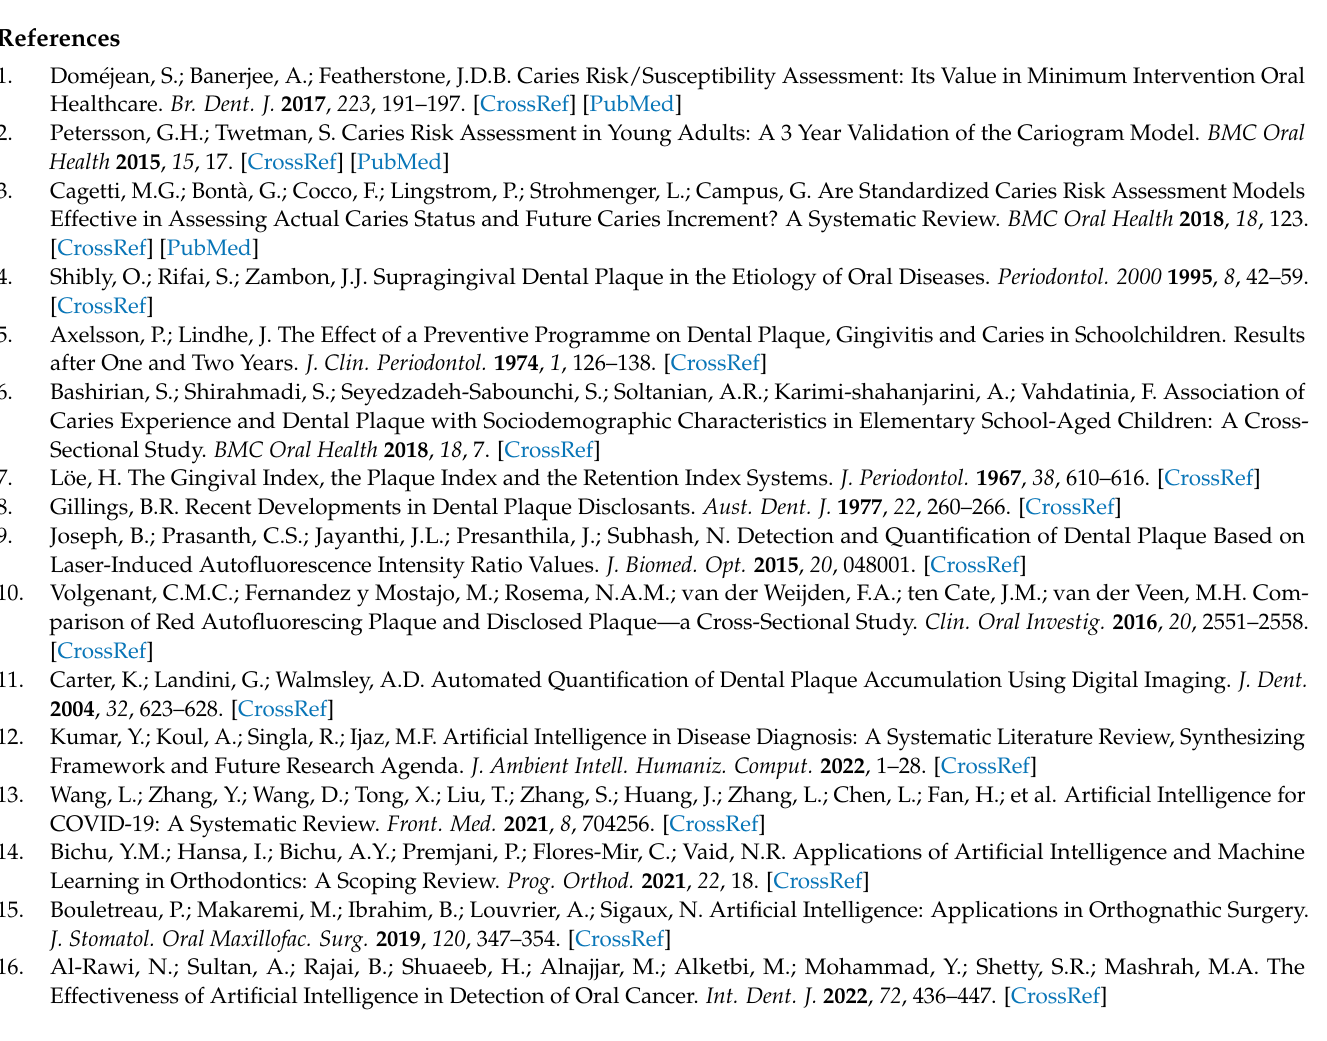
Table A2. Assessment of risk of bias domains and applicability concerns.